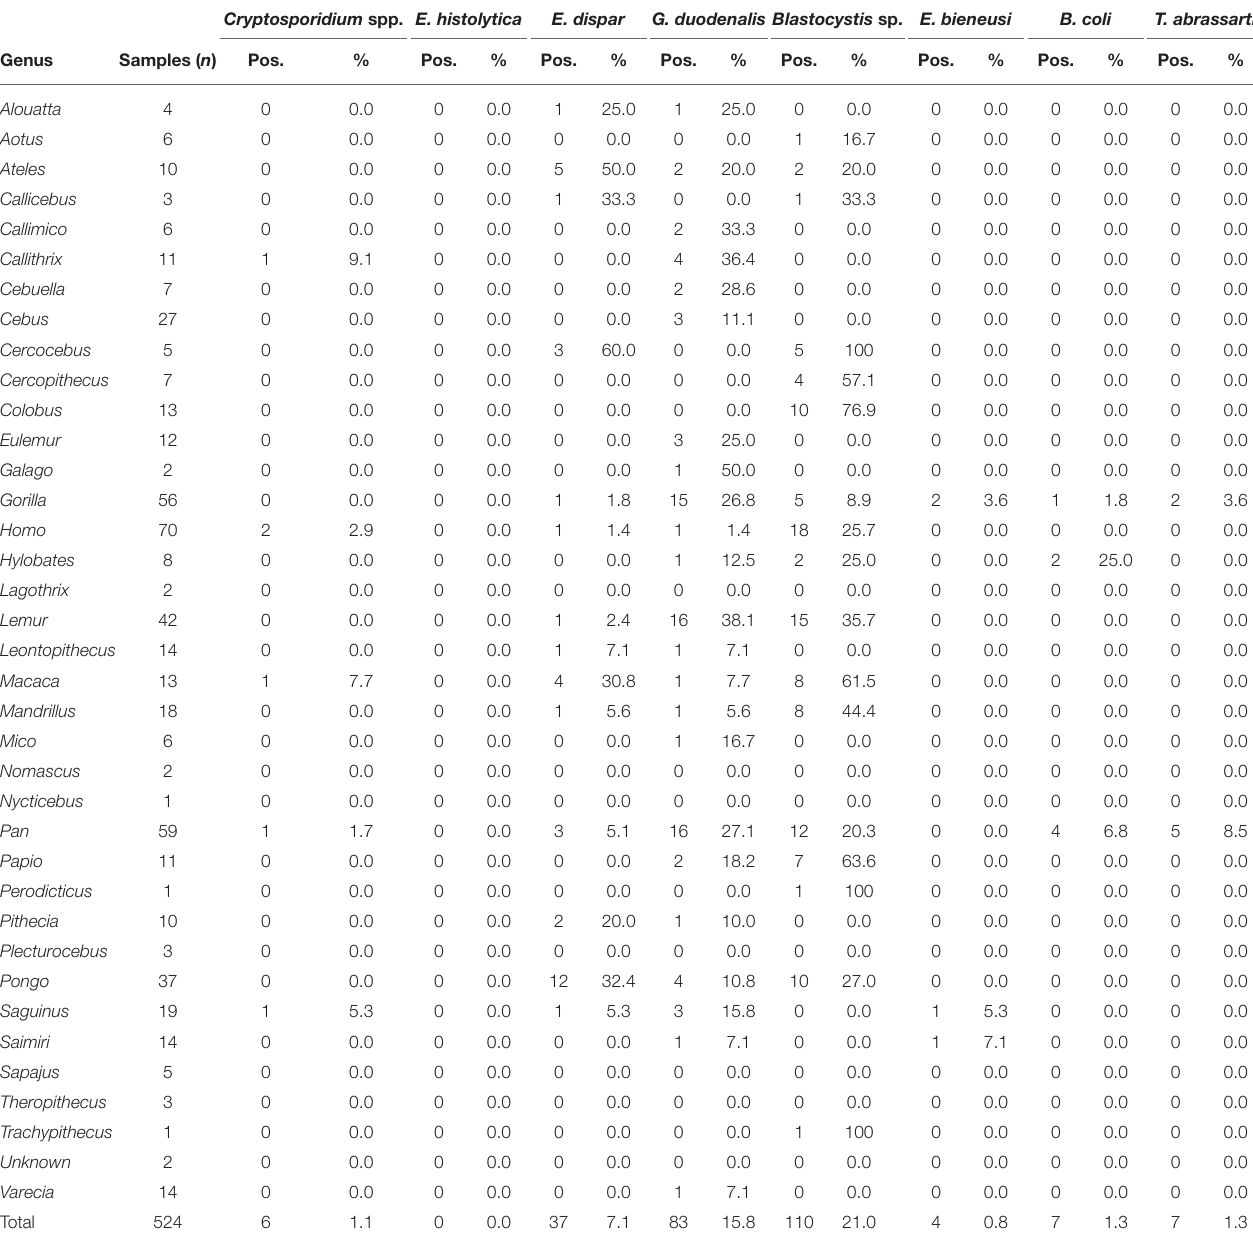
TABLE 2 | Frequency of intestinal protist species detected by primate genera in the present study. Cryptosporidium spp. E.